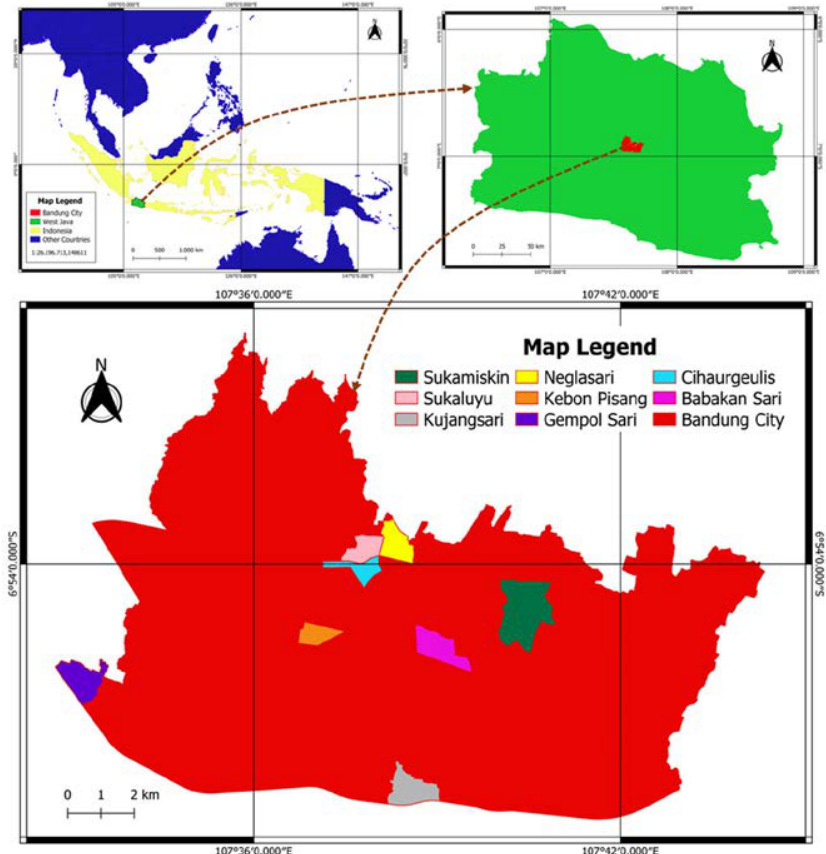
Fig. 1: Geographic location of the study arae plotted using an open source QGIS free software (a) The study area Geographical location in Indonesia and its surrounding continents. (b) West Java map were Bandung City is located (c) The study area with the eight study location points